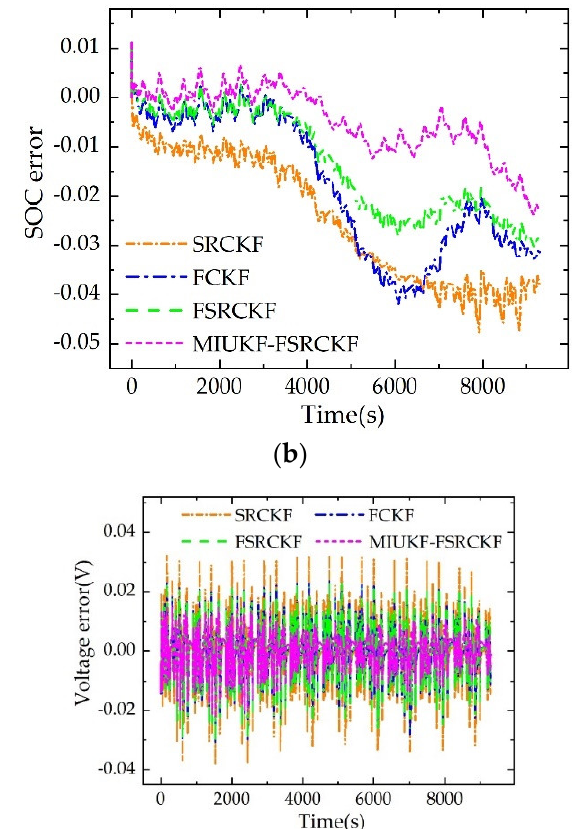
estimation result; ( d ) voltage error.